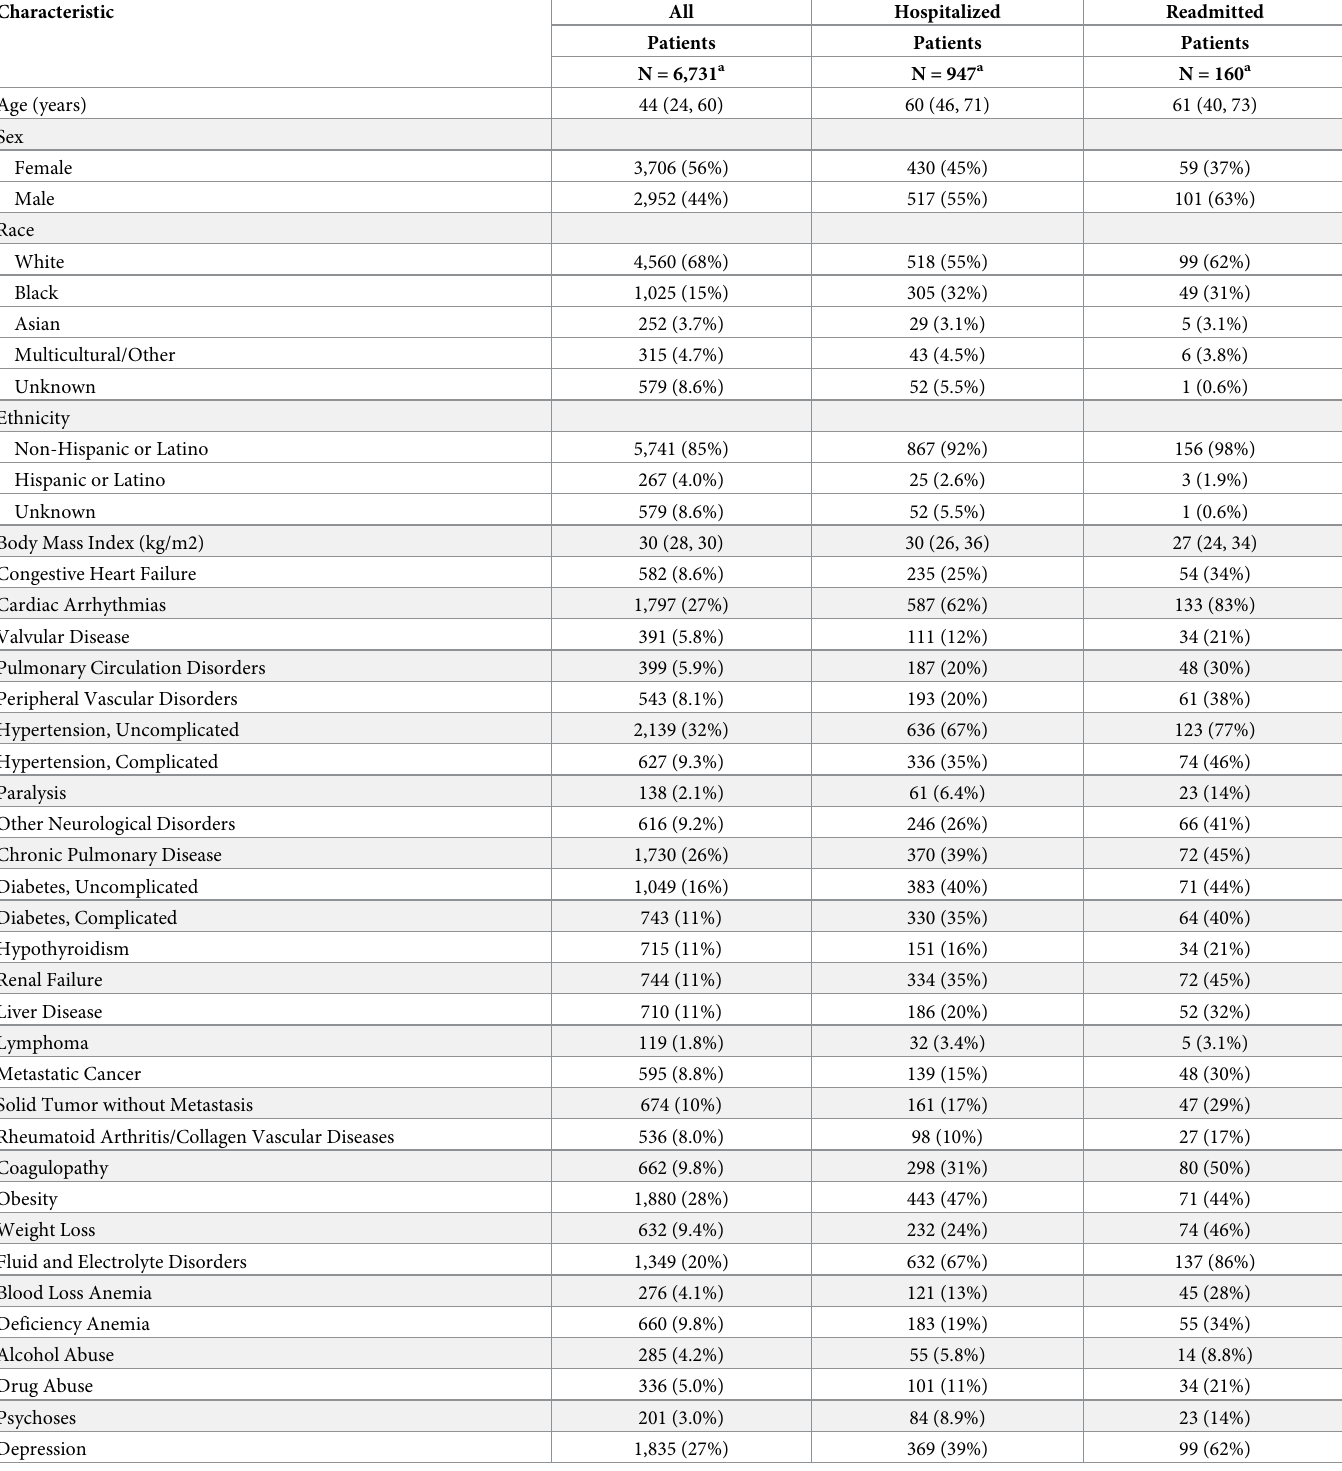
Table 1. Descriptive characteristics for COVID-19 patients treated at Michigan medicine between March 10, 2020 and March 10, 2021. Summary statistics are for the overall population, those admitted for an inpatient stay during the follow-up period, and those readmitted